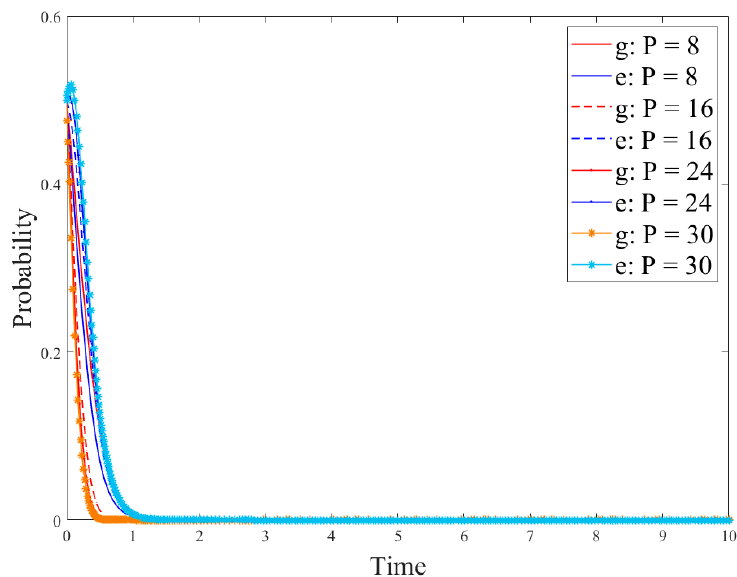
Figure 4. Evolution process of the government ( g ) and enterprises ( e ) with different government penalty P (P : penalty imposed by the government on enterprises that have cheated or produced substandard products ).